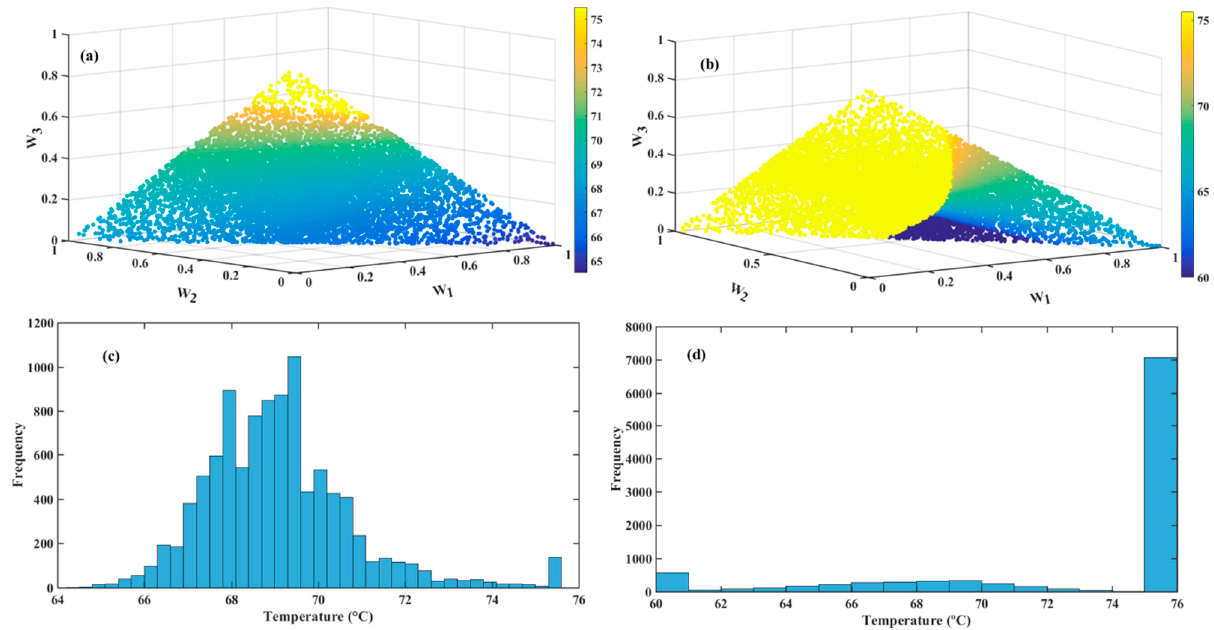
Figure 12. ( a ) Weight plane for the weighted distance aggregating function with 10,000 points. ( b ) Weight plane for the weighted sum aggregating function with the same number of points ( c ) Histogram of the optimal temperature distribution for the weighted distance aggregating function ( d ) Histogram of the optimal temperature distribution for the weighted sum aggregating function.